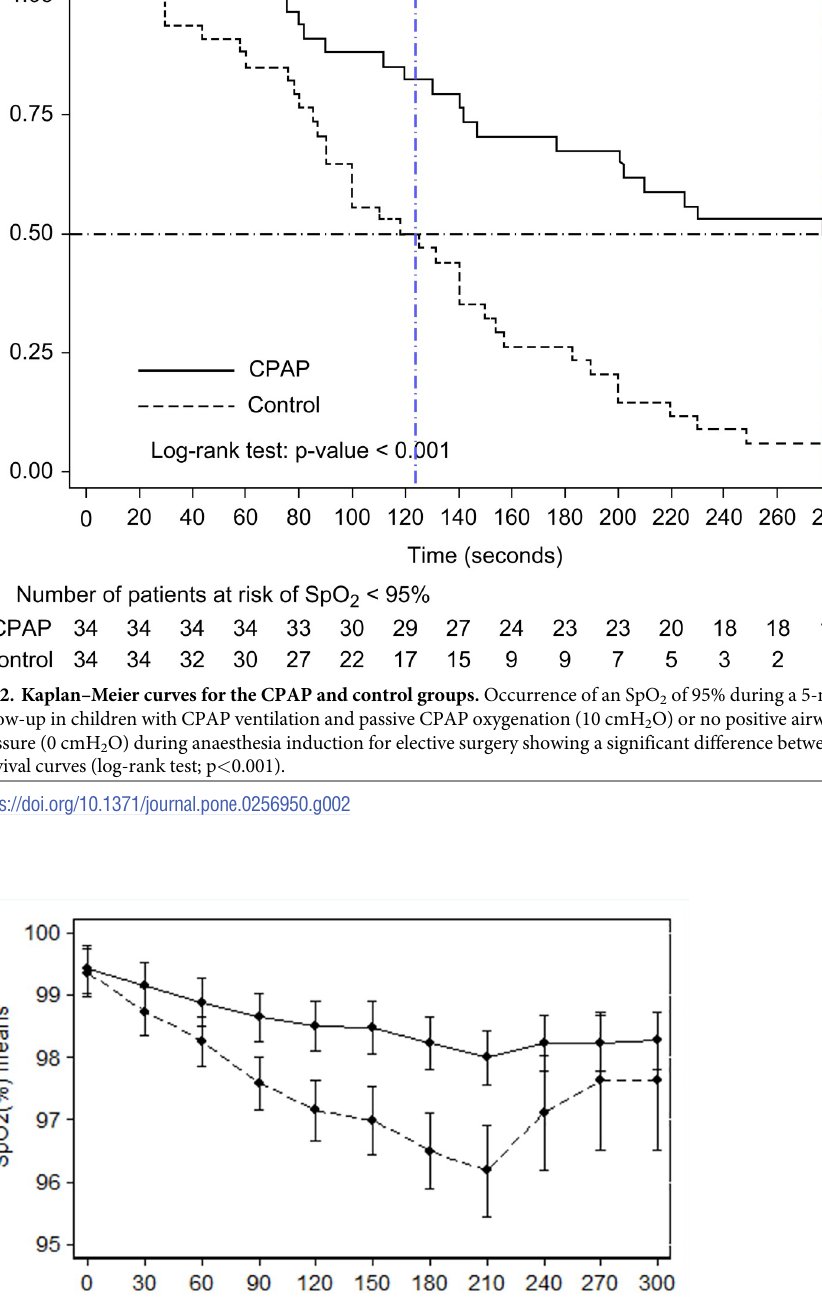
PLOS ONE | https://doi.org/10.1371/journal.pone.0256950 October 1,